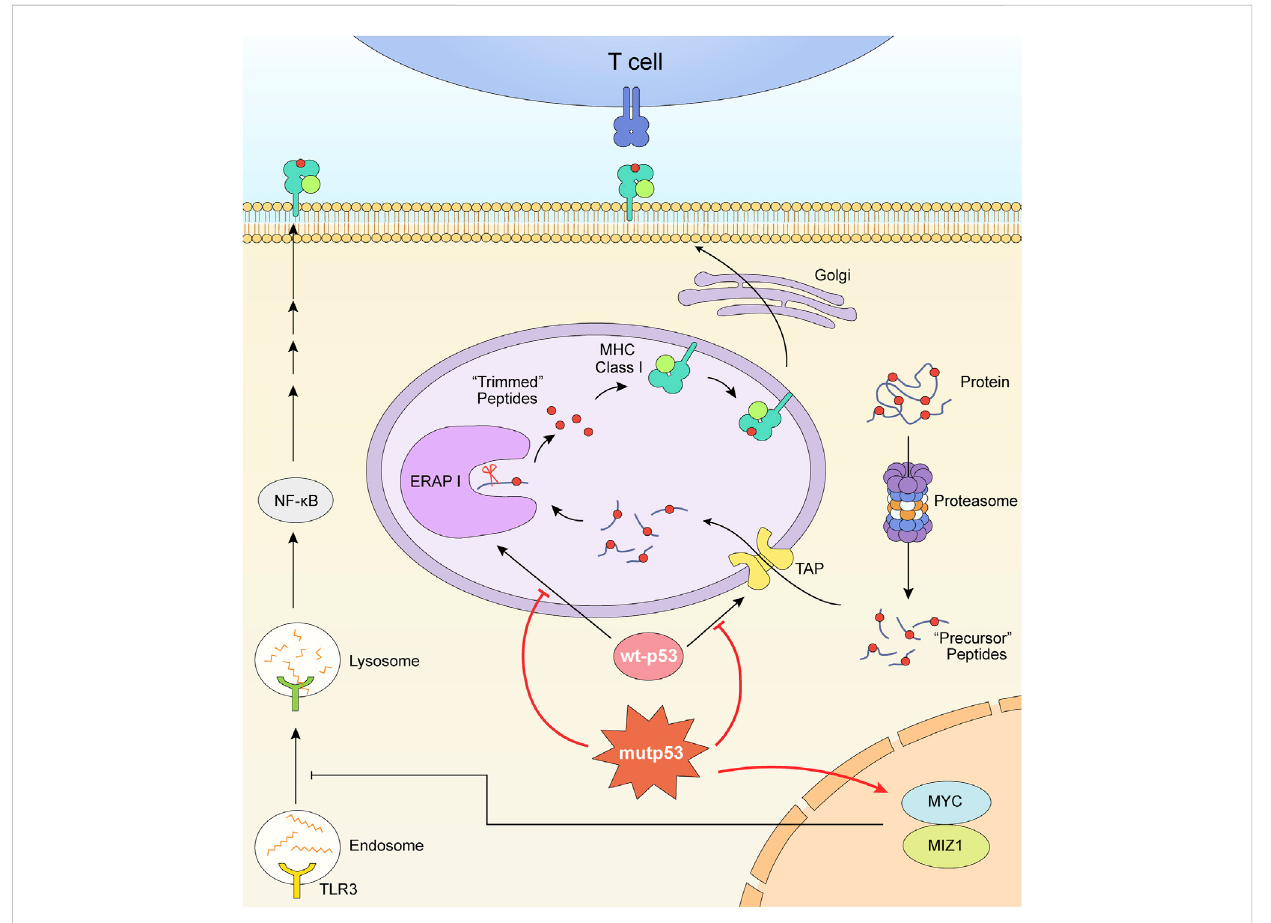
FIGURE 2 Mutant p53 downregulates the expressionof MHC I. The formation and expressionof MHC I is related with TAP and ERAP1.TAP transportspeptides degraded by proteasome into ER. ERAP1 trims these precursor peptides to be optimal length for assembling with MHC. The dysfunctional p53 lost its TAP1andERAP1 activation function. What ’ smore, thep53 mutationand deletion playroles inupregulating MYC oncoprotein,consequentlyinhibitedthe activation of downstream MHC